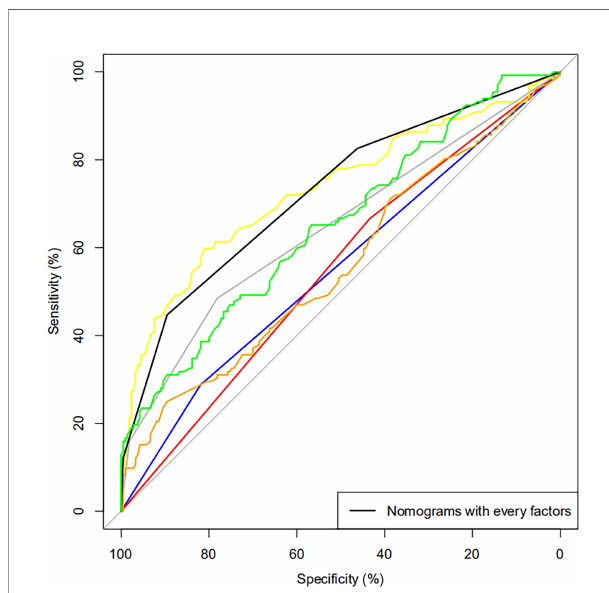
FIGURE 3 | Receiver operating characteristic (ROC) curve of blood transfusion based on logistic regression for each variable. Blue , stapler; red , surgical technique; yellow , hemoglobin (Hb); gray , blood loss; orange , operation time; black , preoperative controlling nutritional status (CONUT); green , triglyceride – glucose (TyG).